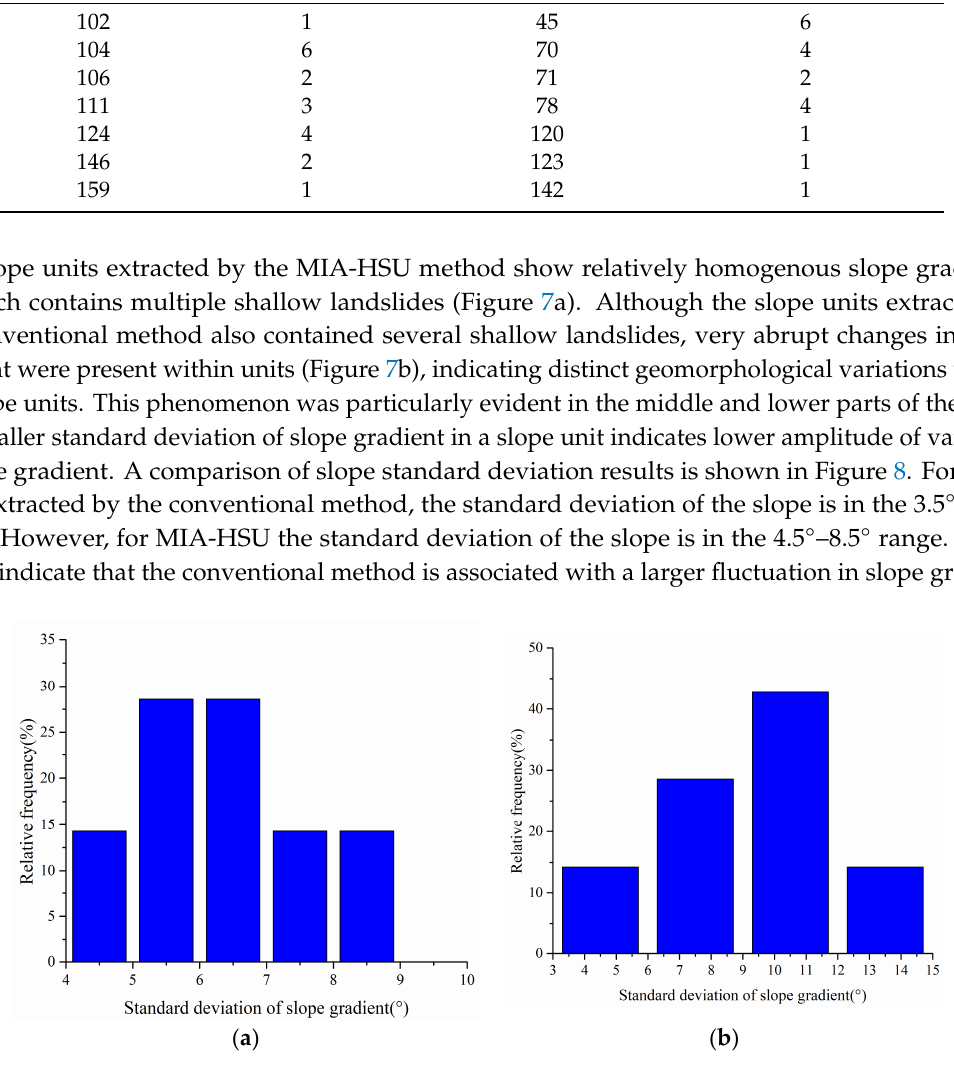
Figure 8. Standard deviation of slope gradient of slope unit; ( a ) the MIA-HSU method and ( b ) the conventional method.